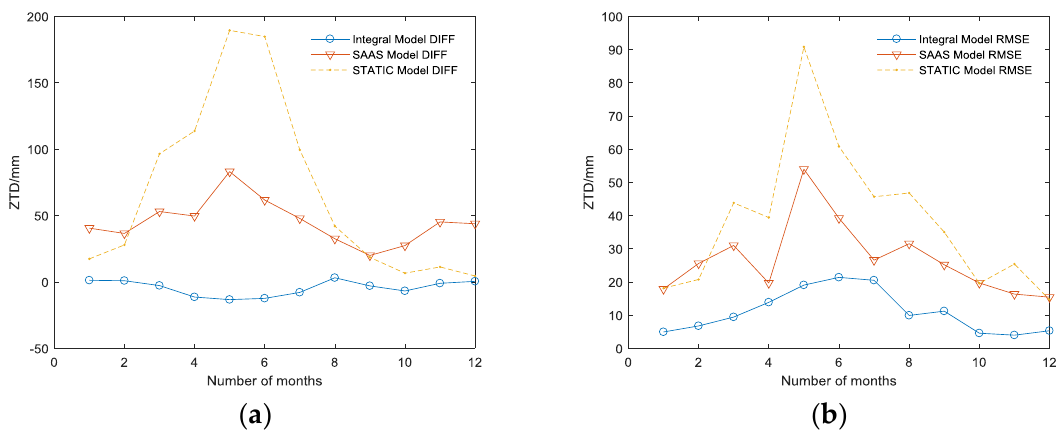
Figure 4. ( a ) The IGS ZPD variations and ZTD variations of the three models in December; ( b ) The DIFF between ZTD of three models and IGS ZPD in December. DIFF between ZTD of three models and IGS ZPD in December.